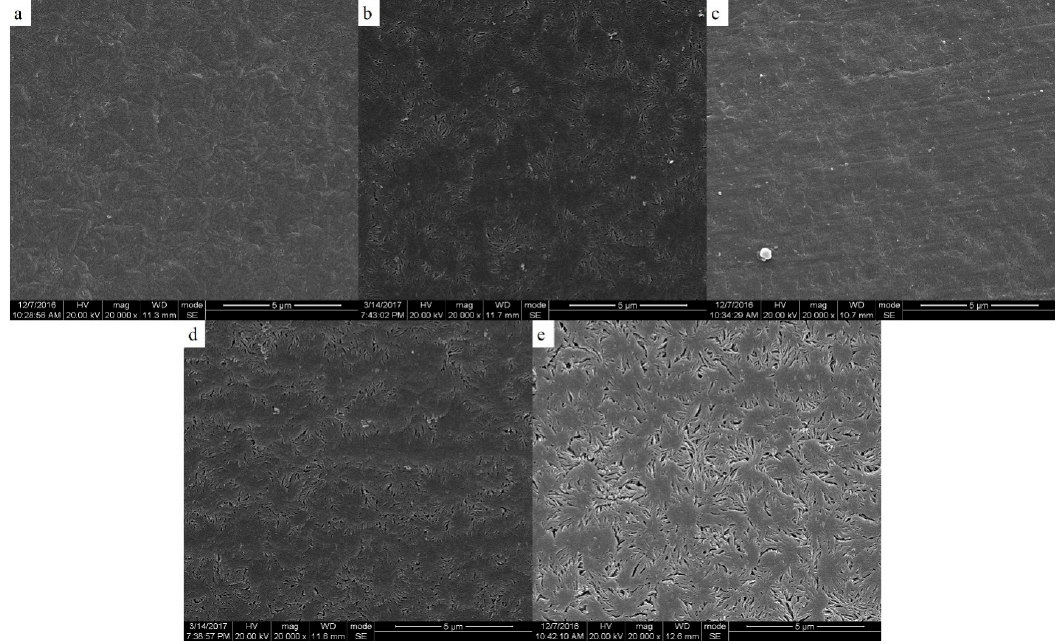
Figure 7. Scanning electron micrographs of the inner surface of membrane; samples were cold crystallized at ( a ) 240 °C; ( b ) 250 °C; ( c ) 260 °C; ( d ) 270 °C; ( e ) 280 °C .